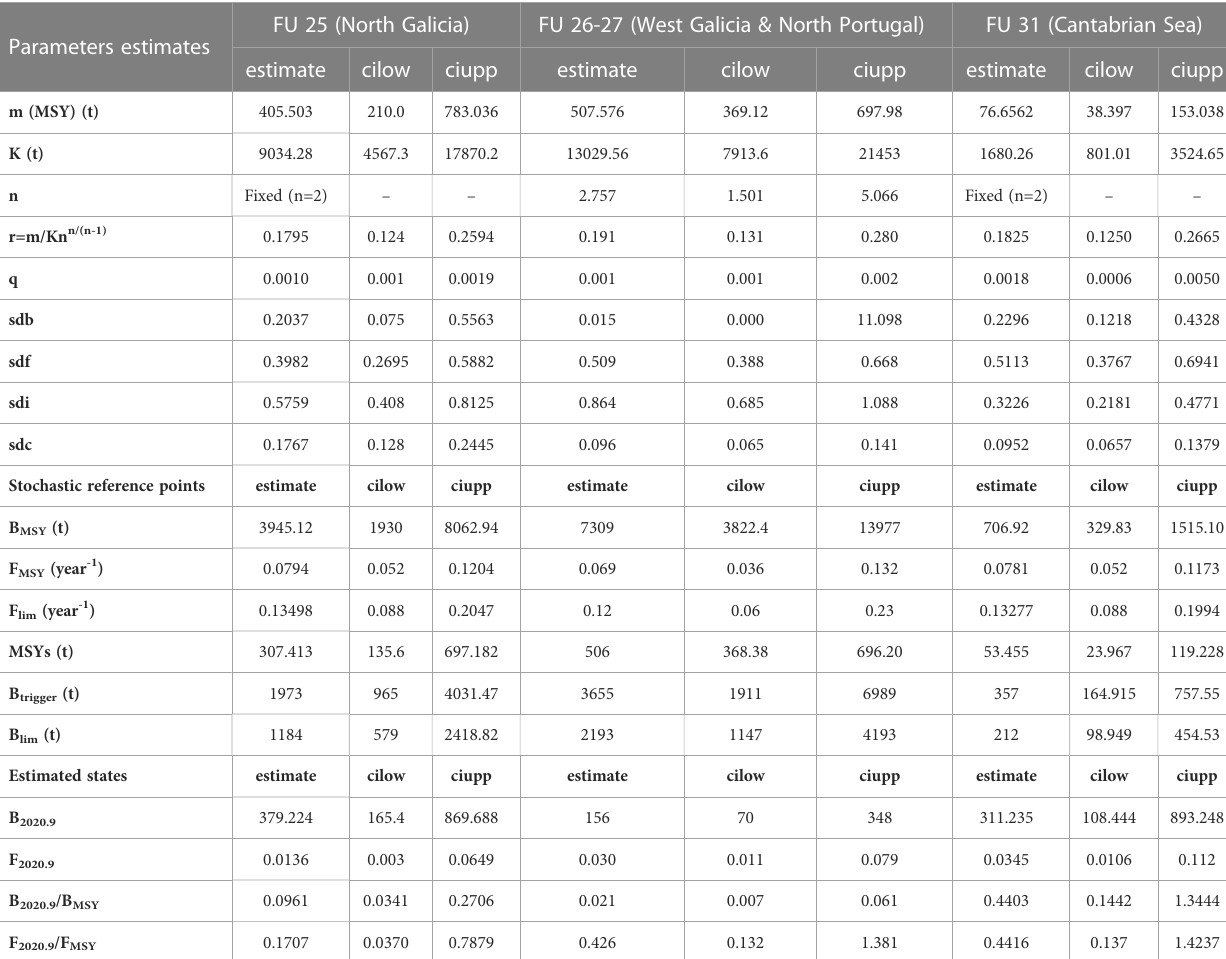
TABLE 2 SPiCT summary results. 95%